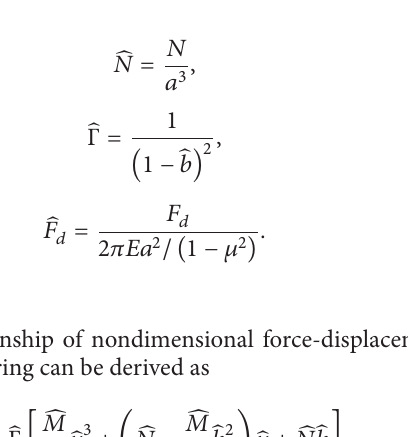
Figure 4: Disk spring with thickness varying along the generatrix of the